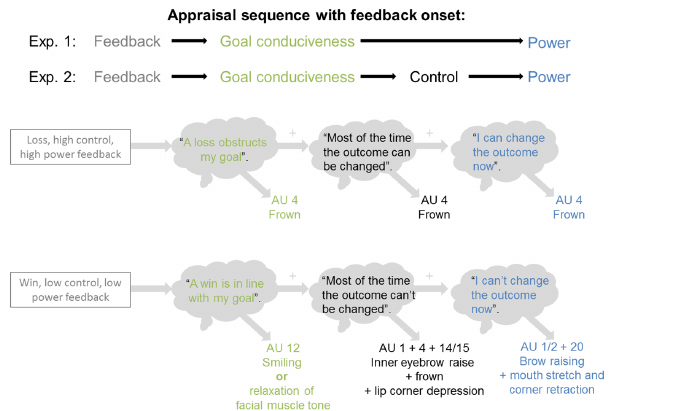
Fig 1. Illustration of sequential and cumulative effects of appraisals on facial expressions predicted by the Component Process Model. The numbers indicate the Action Unit (AU) according to the Faction Action Coding System [37] which are accompanied by descriptions of the respective facial